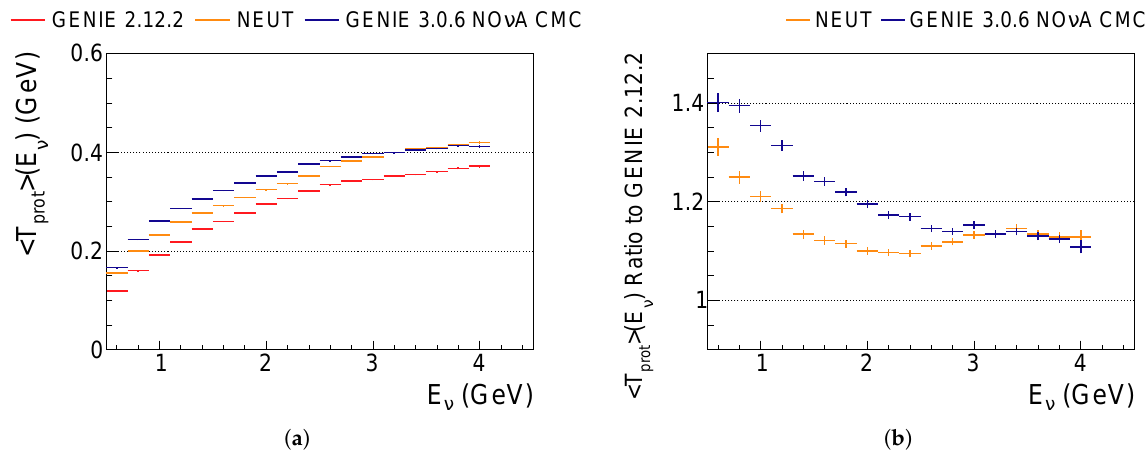
Figure 91. The DUNE-flux-averaged mean kinetic energy to protons as a function of neutrino energy as predicted by the GENIE v2.12.2, NEUT, and GENIE v3.0.6 simulations. ( a ) shows the absolute value for each model and ( b ) shows the ratio of NEUT and GENIE v3.0.6 to the value for GENIE v2.12.2. Model differences on the order of the proposed mock data set can be seen over the energy range that drives the experimental sensitivity to neutrino oscillation parameters. The NO ν A CMC refers to the GENIE ‘Comprehensive Model Configuration’ N18_10j_02_11a , that was developed for the 2020 NO ν A oscillation